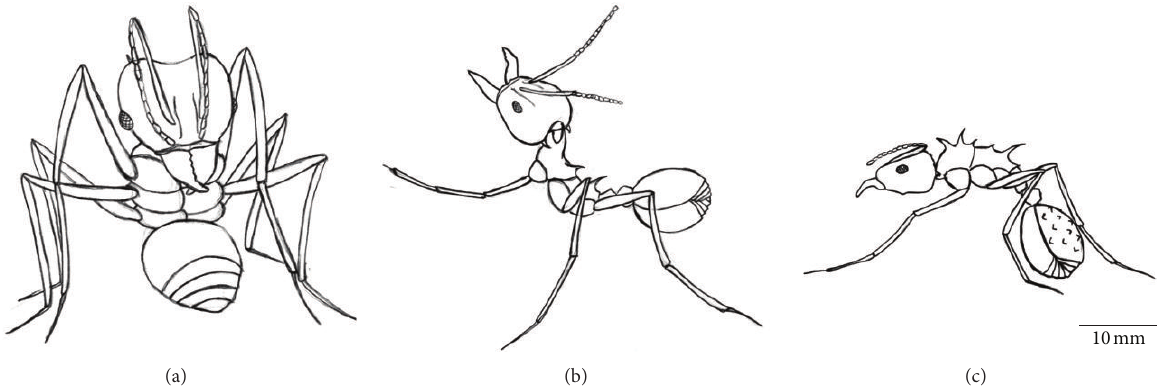
Figure 1: Atta (a, b) and Acromyrmex (c) morphological differences and exhibiting different body postures. (a) shows the C posture, (b) the alarm/attack phorid posture whereas (c) exhibits lowering the abdomen to avoid oviposition at the tip of the gaster.